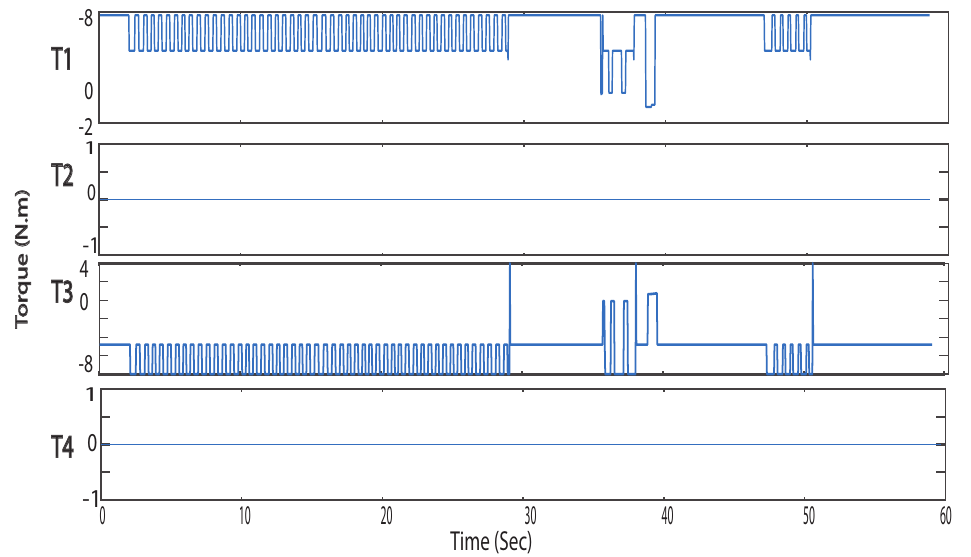
Figure 13. Simulation Results for State 3: Torque of motor 1,2,3,4.